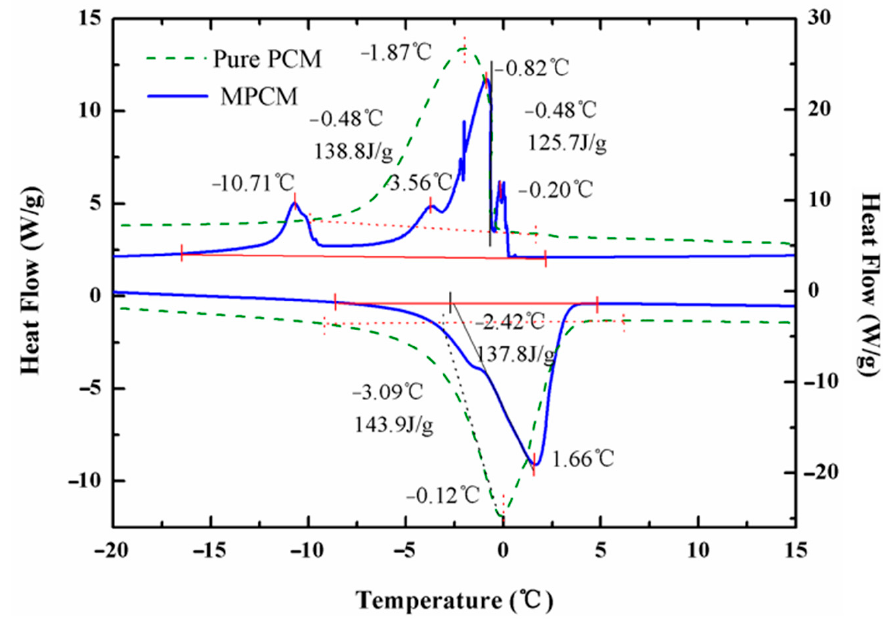
Figure 6. The DSC curves of MPCM and pure PCM during phase transition.